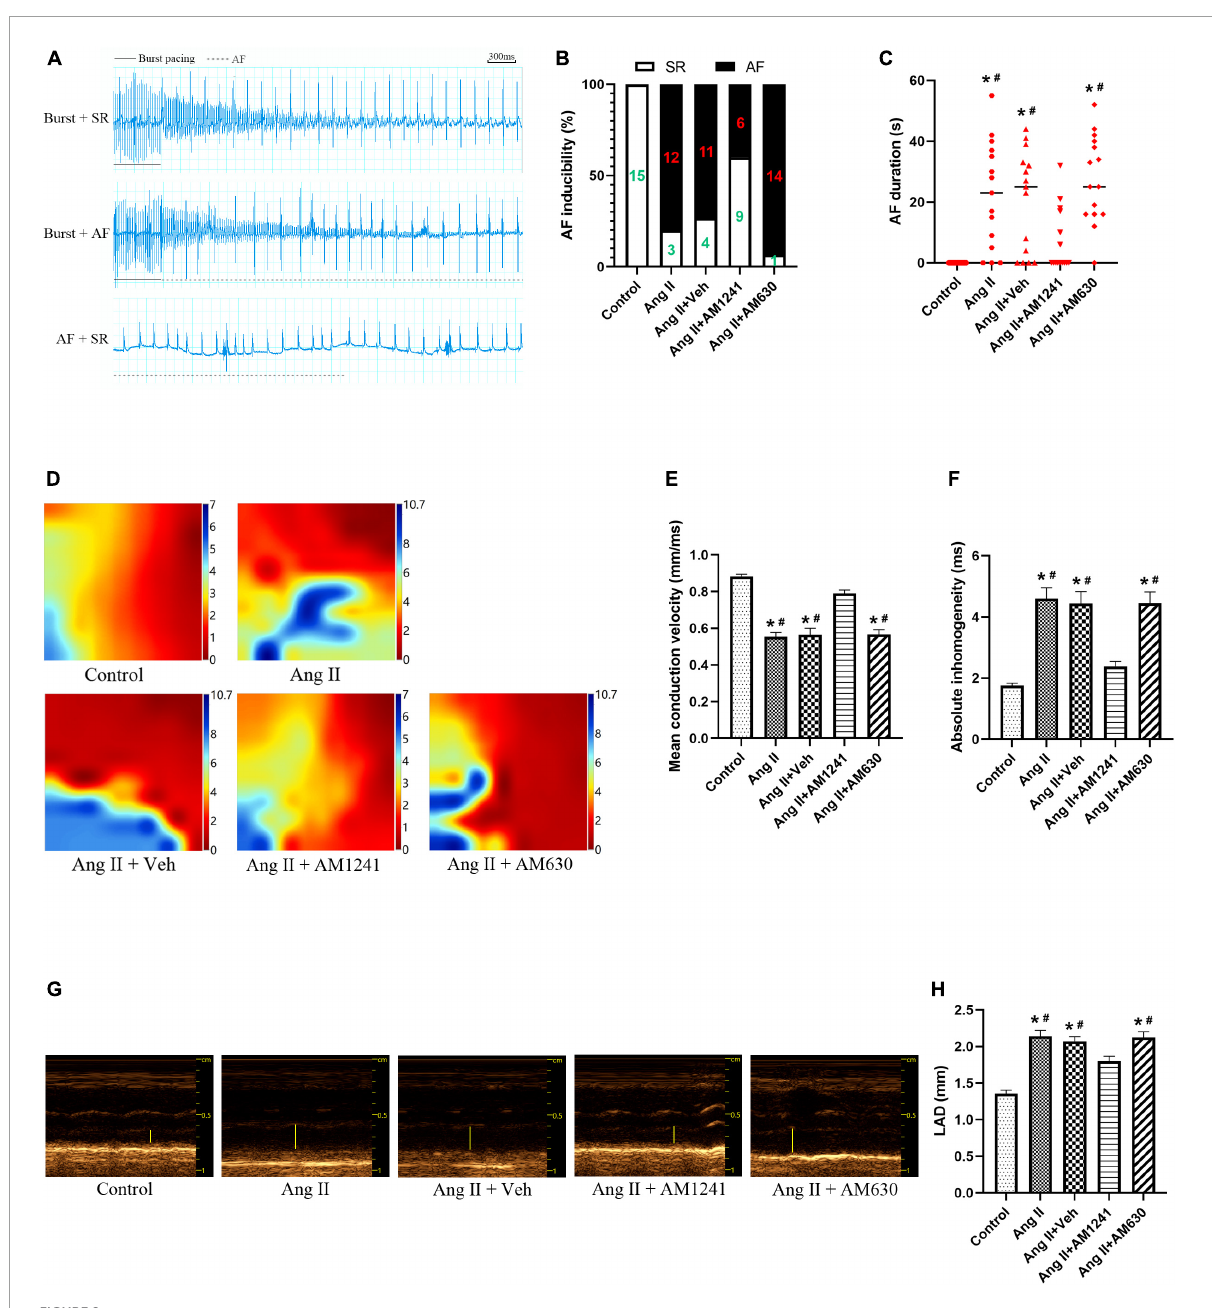
FIGURE2 Administration of AM1241 reduced the inducibility of atrial fibrillation (AF) in Angiotensin II-infused mice. (A) Simultaneous recordings of surface electrocardiogram (ECG) after 21-day infusion of Ang II (2,000 ng/kg/min). Solid underlines indicate the burst pacing period, and dashed underlines highlight the AF period. The above two ECGs recorded representative ECG waves of AF and SR after a burst of electrical stimuli. The bottom recorded ECG waves of AF followed by spontaneous conversion to SR. Bar = 300 ms. (B) Inducibility of AF. (C) Duration of AF. (D) Electrophysiological mapping images of spontaneous conduction in the LA. The bars from red to blue indicate the total time from the first to the last measurement within one heartbeat. (E) Mean conduction velocity. (F) Absolute inhomogeneity of left atrial electrical conduction. (G) Representative M-mode echocardiography of the LA. (H) Quantification of LAD. The data represent the mean ± SEM. * P < 0.05 vs. control group. # P < 0.05 vs. Ang II + AM1241 group.